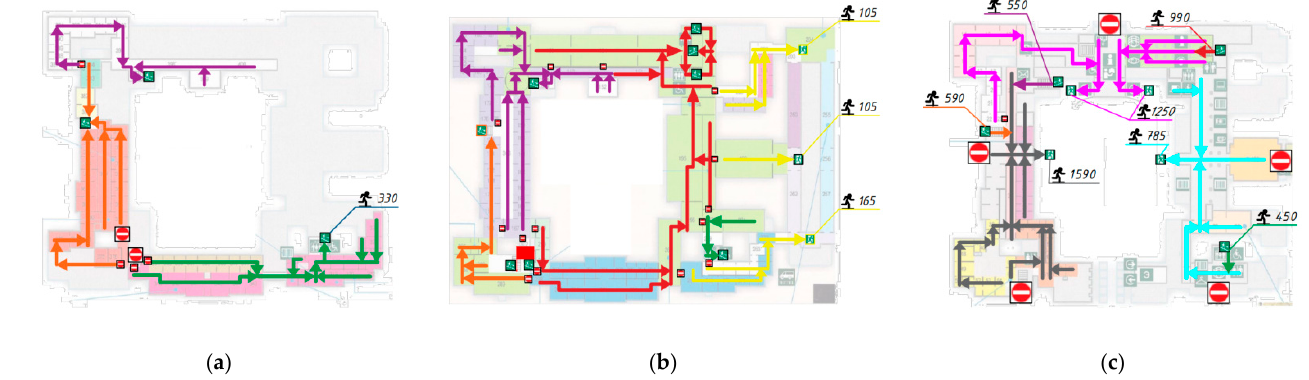
Figure 15. Scheme of evacuation of people from the Winter Palace for the scenario “Fire in the Com- mandant’s Cloakroom”: ( a ) for the 3rd floor; ( b ) for the 2nd floor; and ( c ) for the 1st floor.